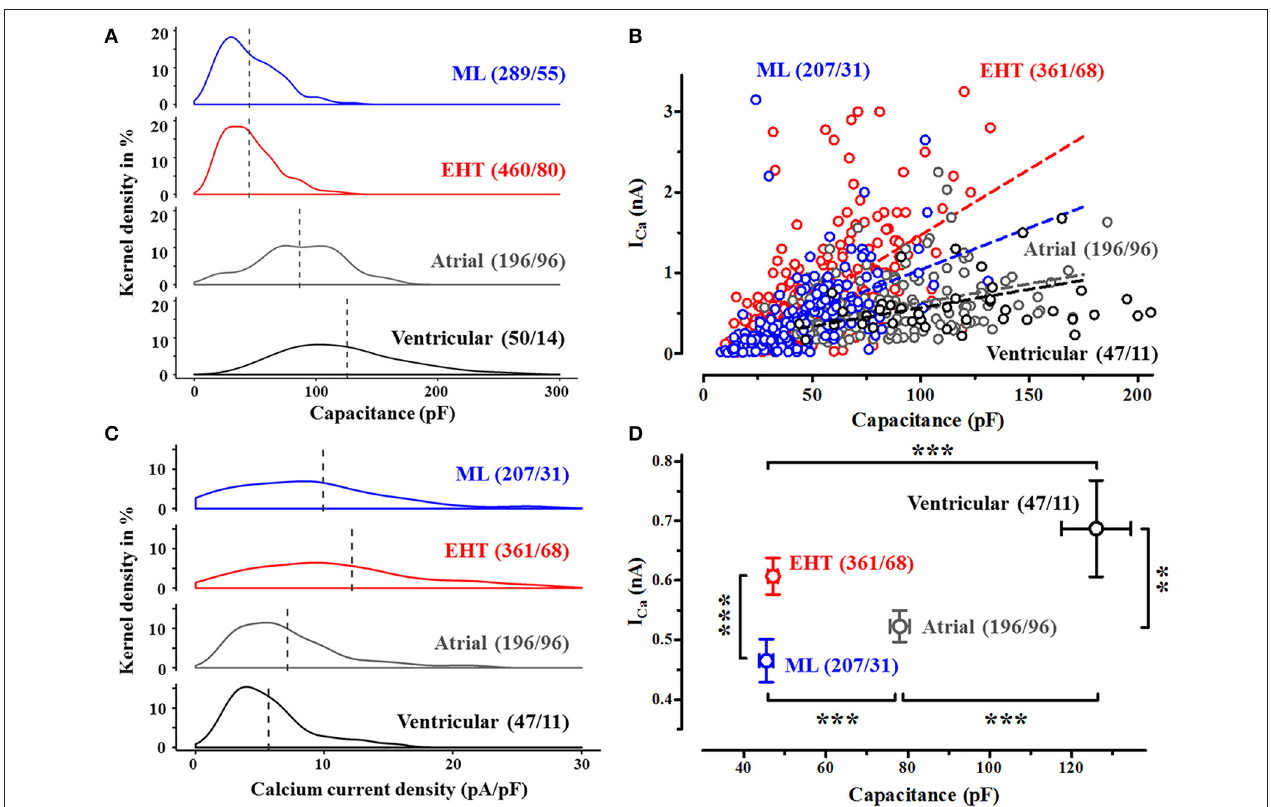
FIGURE 1 | Cell size and Ca 2 + -currents in human CM. (A) Frequency distribution of cell capacitance in CM from conventional monolayer culture (ML), EHT and from human adult atrial and ventricular CM expressed as kernel density (details see methods). Dotted lines indicate mean values (compare Table S2). (B) Ca 2 + -current amplitudes (measured at + 10 mV) vs. cell capacitance, dotted lines indicate linear regression fit (compare Table S3). Cells without ICa were not plotted. Same n-numbers as in 1C. (C) Frequency distribution of Ca 2 + -currents in human CM. Ca 2 + -currents are expressed as current densities, measured 3.5 min after membrane rupture (test- pulse potential + 10 mV, for detailed analysis compare Table S4). (D) Mean values for absolute peak Ca 2 + -currents vs. cell capacitance. Please note that error bars may be smaller than symbols. Same n-numbers as in 1C. N/N indicates number of cells vs. number of isolation for ML and EHT and number of cells/number patients for atrial and ventricular